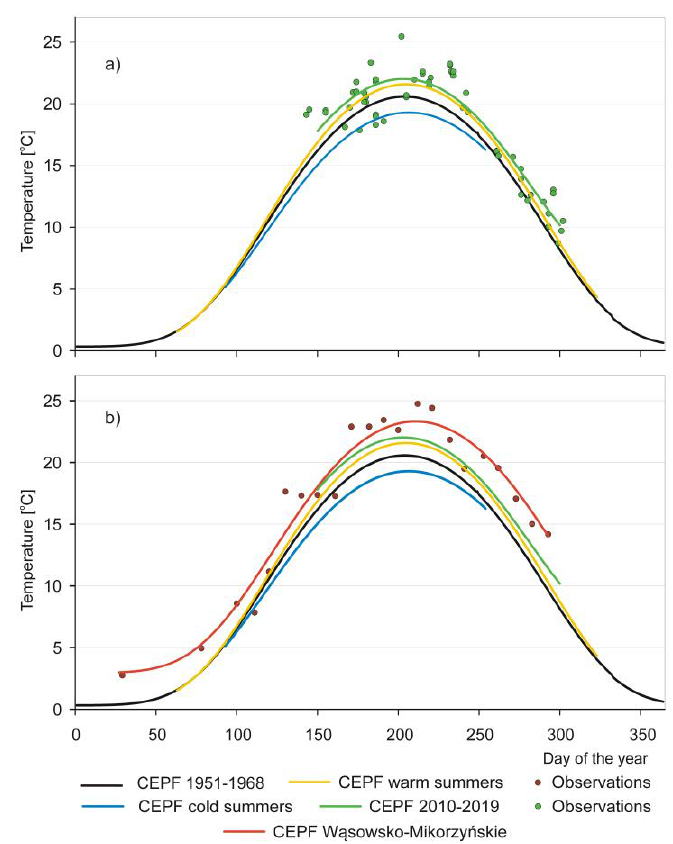
Figure 9. The in situ measurements of the water temperature (average in the layer 0 – 3 m) in Polish lakes ( a ) in the years 2010 – 2019 and ( b ) in heated Lake Wąsowsko - Mikorzyńskie in 1969 (data after [56]), with linear interpolation to calculate the daily temperature. CEFP 1951 – 1968 — complementary error peak function for the 1951 – 1968 period — Equation (1); CEFP warm summer — complementary error peak function for the years with the warm summer in the 1951 – 1968 period — Equation (3); CEFP cold summer — complementary error peak function for the years with the cold summer in the 1951 – 1968 period — Equation (4); CEFP Wąsowsko - Mikorzyńskie— complementary error peak function for heated Lake Wąsowsko - Mikorzyńskie in 1969.